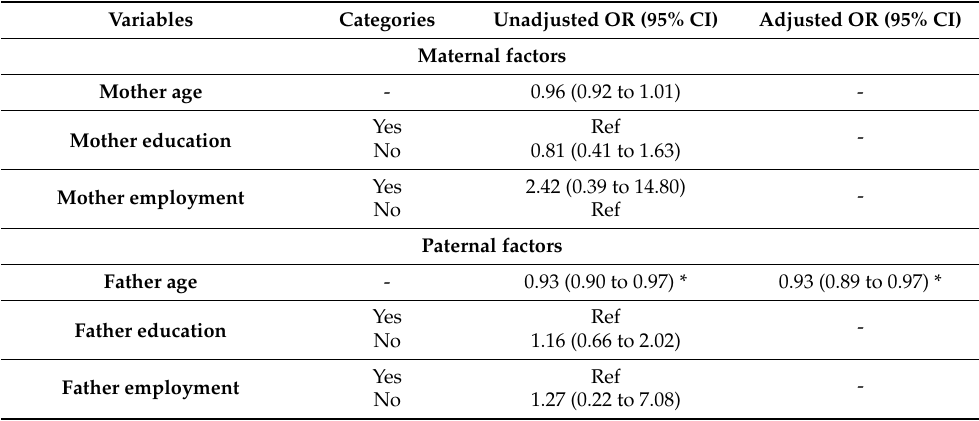
Table 2. Experiences associated with true immunization